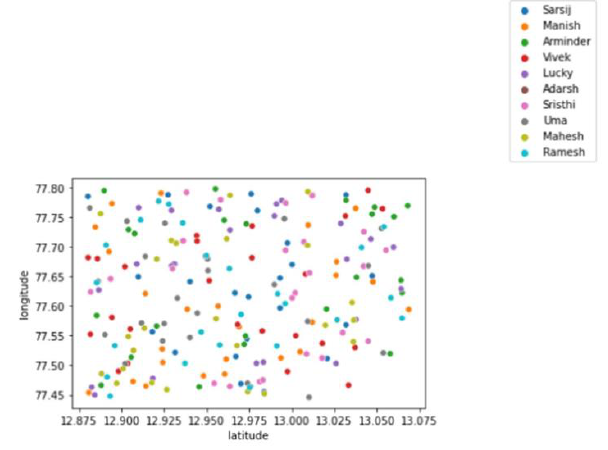
Figure 1. The geographical spread of different people within the data